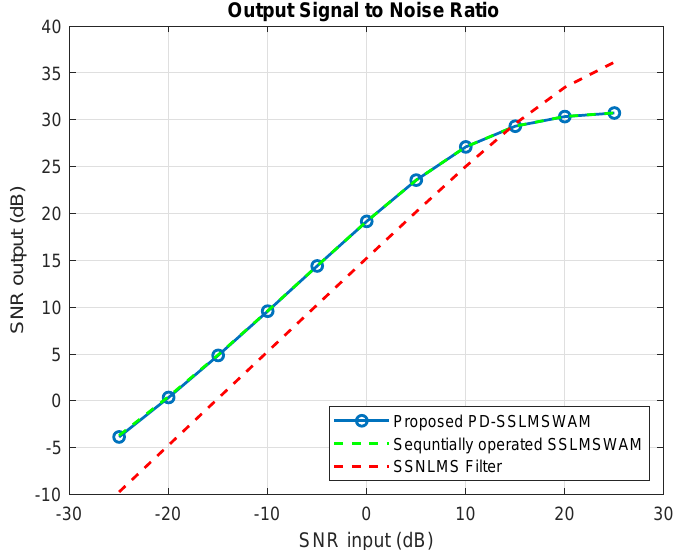
Figure 16. Output signal-to-noise ratio